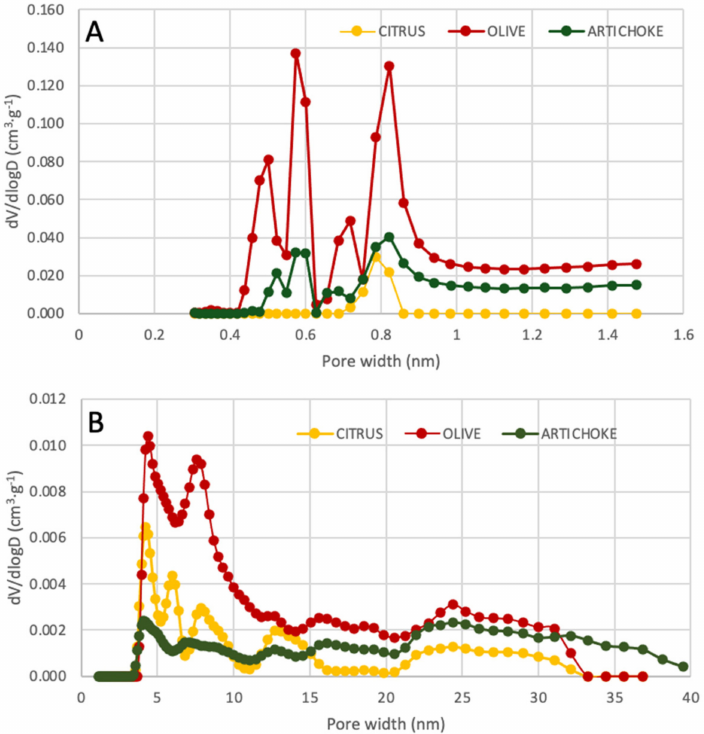
Figure 6. Pore size distribution of the selected agrifood wastes with CO 2 adsorption at 273.15 K ( A ) and with N 2 at 77.3 K ( B